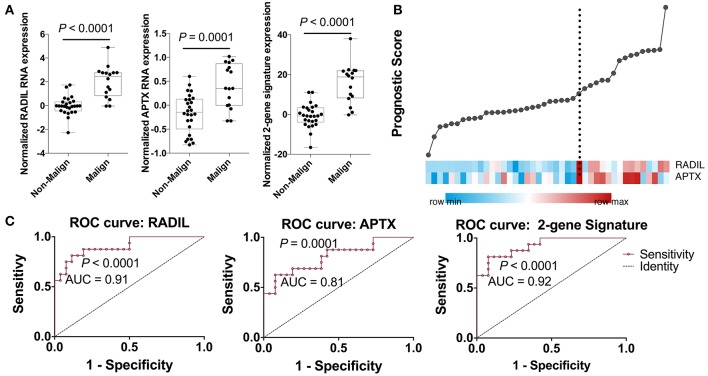
Establishment of the gene prognostic model. (A) RADIL and APTX expression between the malign group and non-malign group. (B) RADIL-APTX based prognostic model for diagnosis for all those subjects and those with higher prognostic scores demonstrated a tendency toward the expression of high-risk genes. (C) ROC curves of RADIL and APTX and 2-gene signature, in which we could find RADIL has a similar AUC (AUC = 0.91) value with that of 2-gene signature (AUC = 0.92).